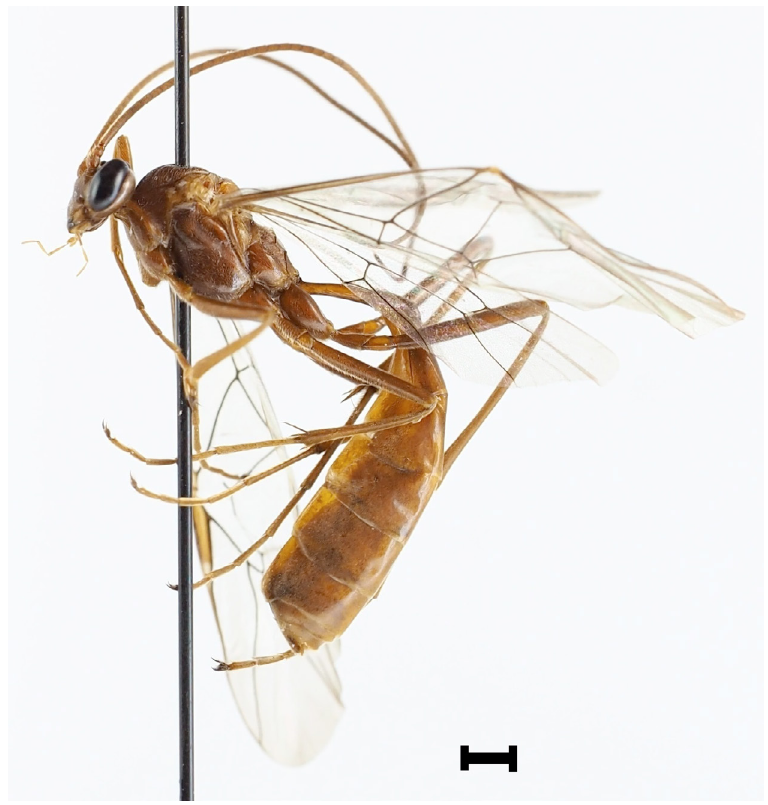
Fig. 25. Ophion autumnalis Johansson sp. nov., holotype, ♀ (NHRS-HEVA000008620). Scale bar = 1